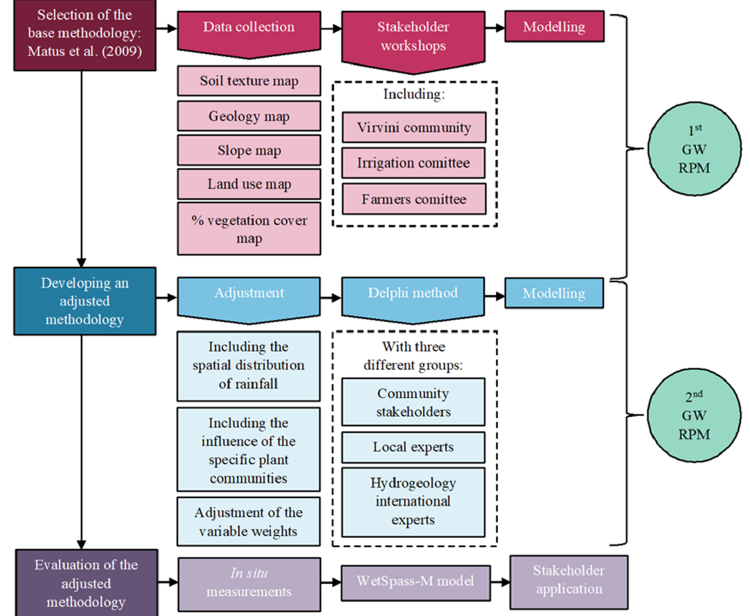
Figure 3. Methodology flowchart with all the steps to develop a groundwater recharge probability map (GWRPM) [46].